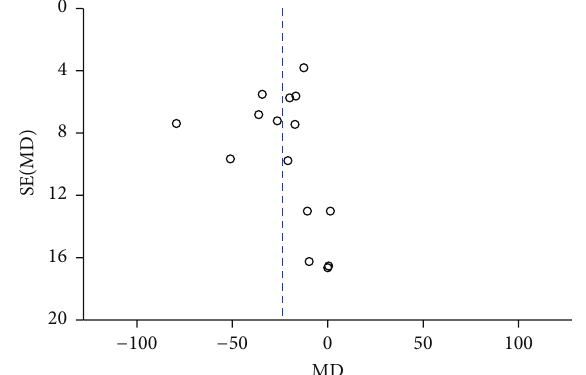
Figure 7: Funnel plots for evaluating the publication bias of average PPCT between the two